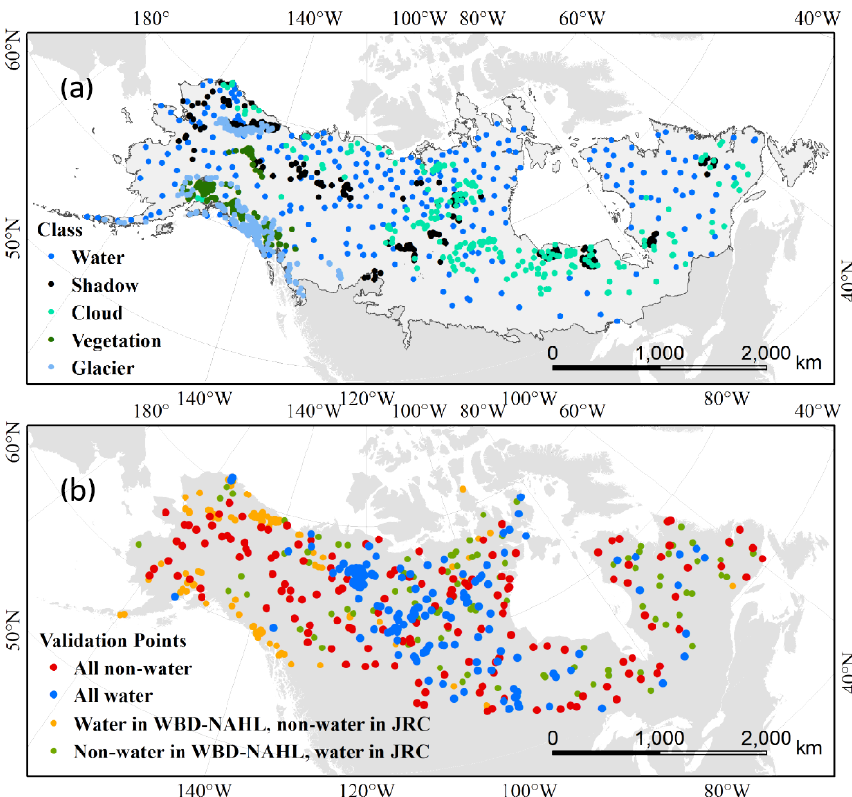
Figure 4. Training samples for random forest model building (a) and points identified for validating the accuracy of the detected water extent (b)